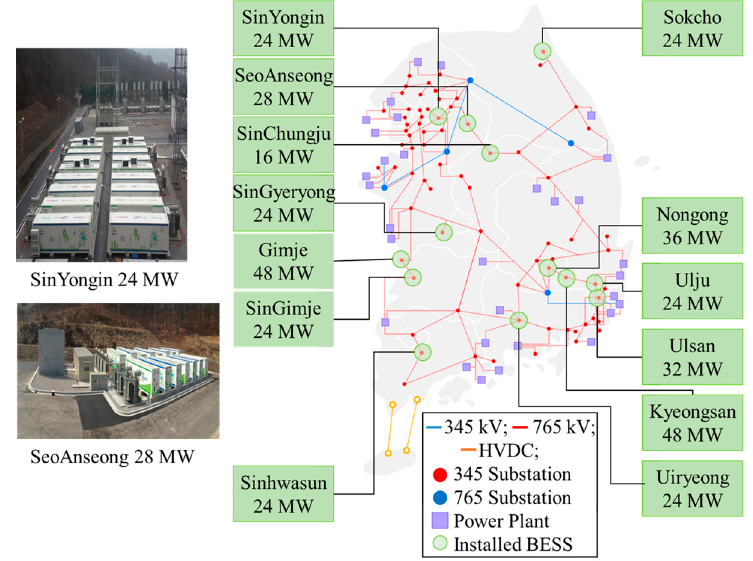
Figure 1. Expansion plan of battery energy storage system (BESS) for a frequency response in the Korean power system. 21